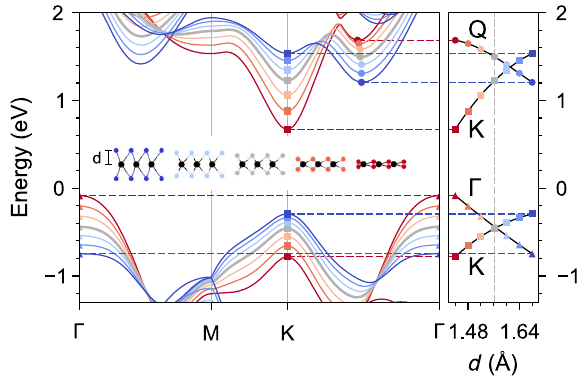
FIG. 8. Variation of the first-principles energy bands of monolayer MoS 2 induced by the displacement pattern of the A 1 mode at Γ (a rigid vertical motion of the chalcogen planes in g opposite directions, with a variation of the distance d between the plane of sulphur atoms and that of molybdenum atoms — see inset). To emphasize the effect, the amplitude of the displacement has been set to 0.12 Å, both in compression (red lines) and dilation (blue lines), with respect to the equilibrium value d ¼ 1 . 57 Å (gray lines). On the right, we report the evolution of the band edges of the K and Q valleys in conduction and of the Γ and K valleys in valence, as a function of d . The same colors as in the left panel have been used to identify different values of d . The absolute value of the slope of each curve at the equilibrium value of d (marked with a vertical dashed line) is proportional to the bare electron phonon coupling of the corresponding band with the A 1 mode at Γ , yielding j g j ≈ 50 – 100 meV depending on the g TMD [78 –